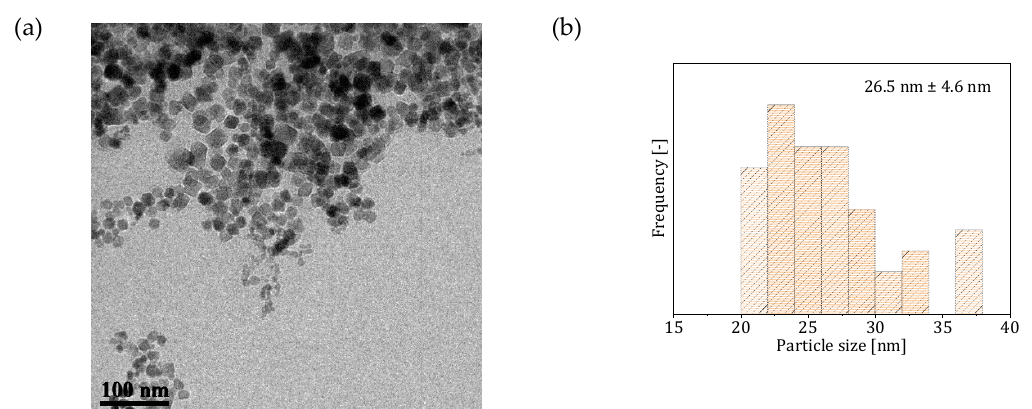
Figure 5. ( a ) TEM micrograph and ( b ) particle size distribution of particles obtained from Reactor System 4.